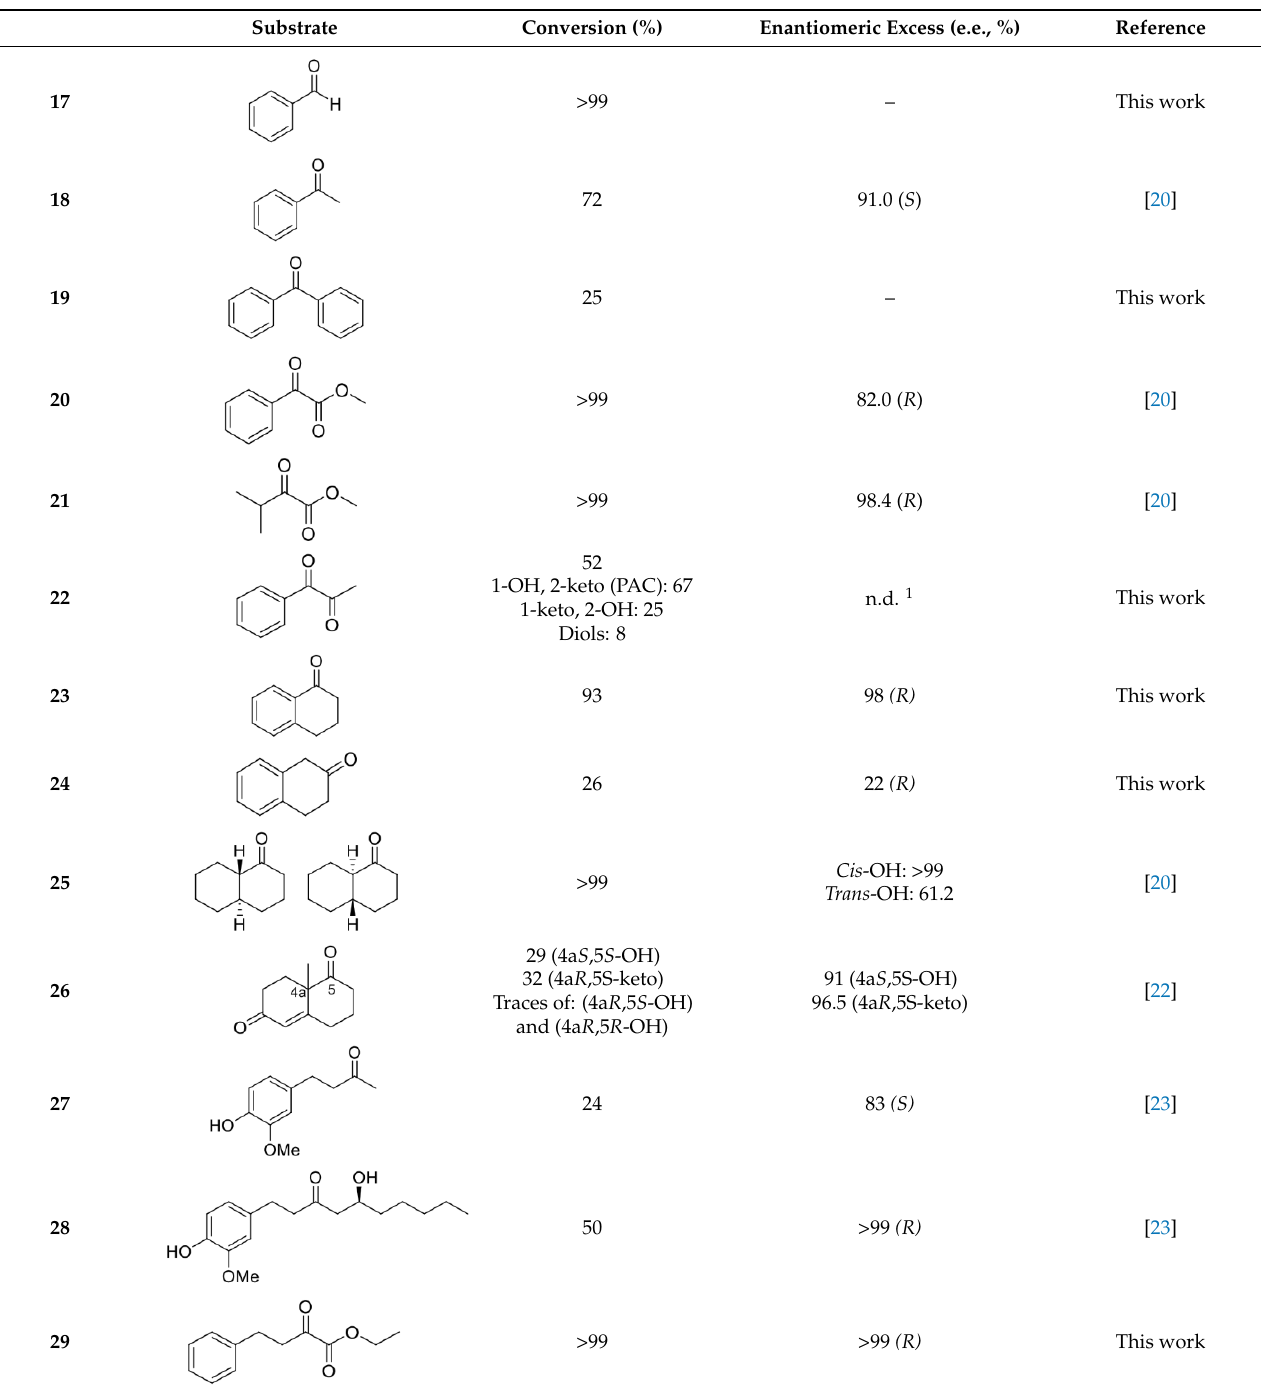
Table 1. Substrate scope, conversion, and stereoselectivity in Is2-SDR-catalyzed reduction of different carbonyl compounds (chemical structure of products is shown in Table S2, supplementary materials).